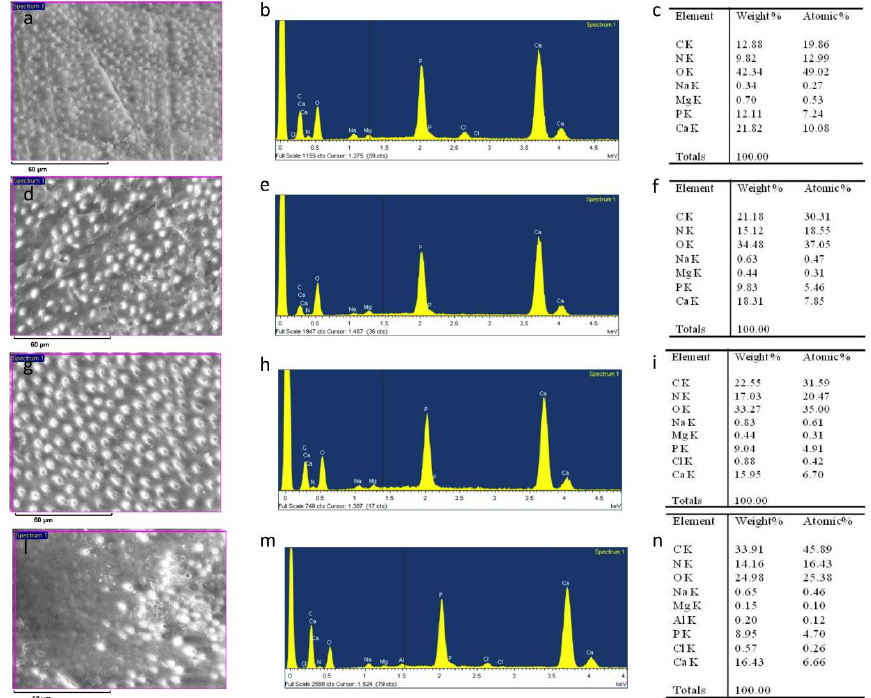
Figure 2. ESEM image, EDX spectra, and table of elements recorded on the dentin surface after sanding with abrasive paper ( a , b , c ), after treatment with a 10% EDTA (Tubuliclean 10%) ( d , e , f ), and after immersion in SBF for 24 h ( g , h , i ) and two months ( l , m , n ).